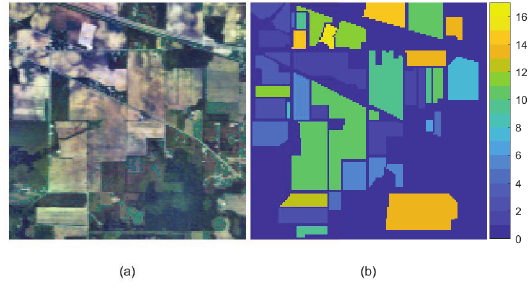
Figure 4. Indian Pines dataset. ( a ) False color image. ( b ) Ground truth.